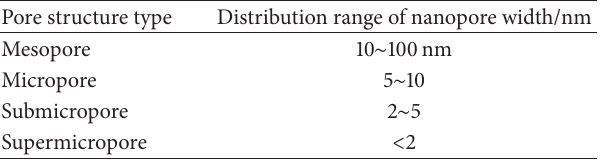
Table 3: Classification of the nanopore structure of deformed